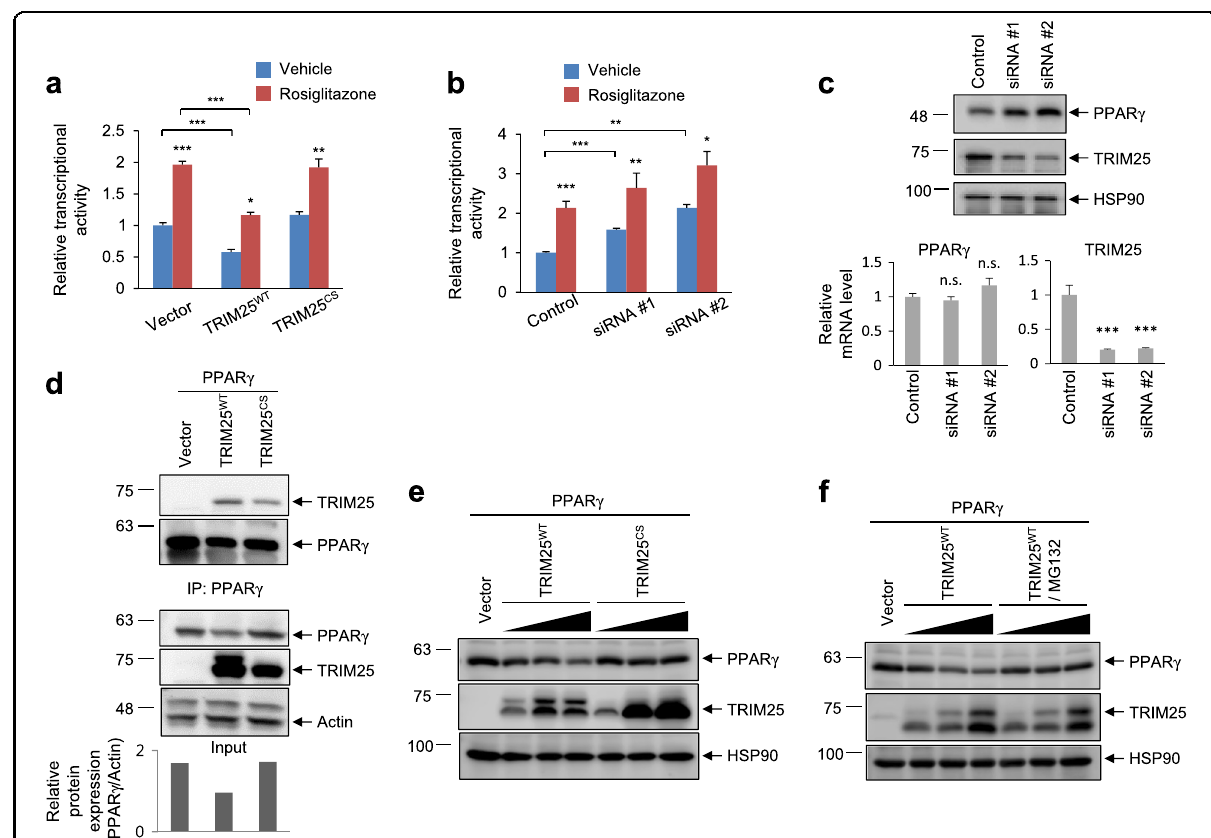
Fig. 2 TRIM25 degrades PPAR γ through the proteasomal pathway. a , b TRIM25 represses the transcriptional activity of PPAR γ . HEK-293 cells were transfected with TRIM25 WT and TRIM25 CS with PPAR γ ( a ) or siRNAs against TRIM25 (#1 and #2) with PPAR γ ( b ) with or without rosiglitazone. Cells were analyzed with a luminometer ( n = 3). c The TRIM25 protein level was increased by TRIM25 siRNAs in HCT116 cells. The PPAR γ and TRIM25 protein levels were analyzed by western blotting, and their mRNA levels were analyzed by real-time quantitative PCR (RT-qPCR) ( n = 3). d HEK-293 cells were transfected with PPAR γ , TRIM25 WT , or TRIM25 CS . The interaction between TRIM25 and PPAR γ was analyzed by western blotting. Relative PPAR γ protein levels were measured using ImageJ (bottom graphs). e HEK-293 cells were transfected with TRIM25 WT or TRIM25 CS with PPAR γ in dose- dependent manner. Indicated proteins were measured by western blotting. f HEK-293 cells were transfected with TRIM25 WT with PPAR γ in dose- dependent manner with or without MG132 (10 μ M for 6 h). The indicated proteins were measured by western blotting. All error bars shown are the s. e.m. (* p < 0.05, ** p < 0.01, *** p <